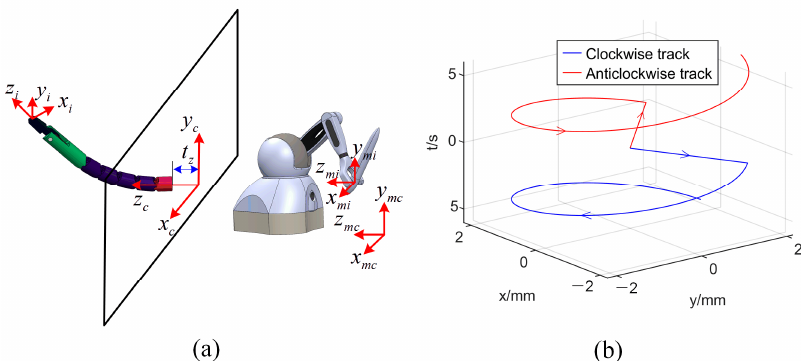
Figure 8. ( a ) Mapping relationship between the haptic device and manipulator; ( b ) two reference trajectories of the manipulator starting from the origin.